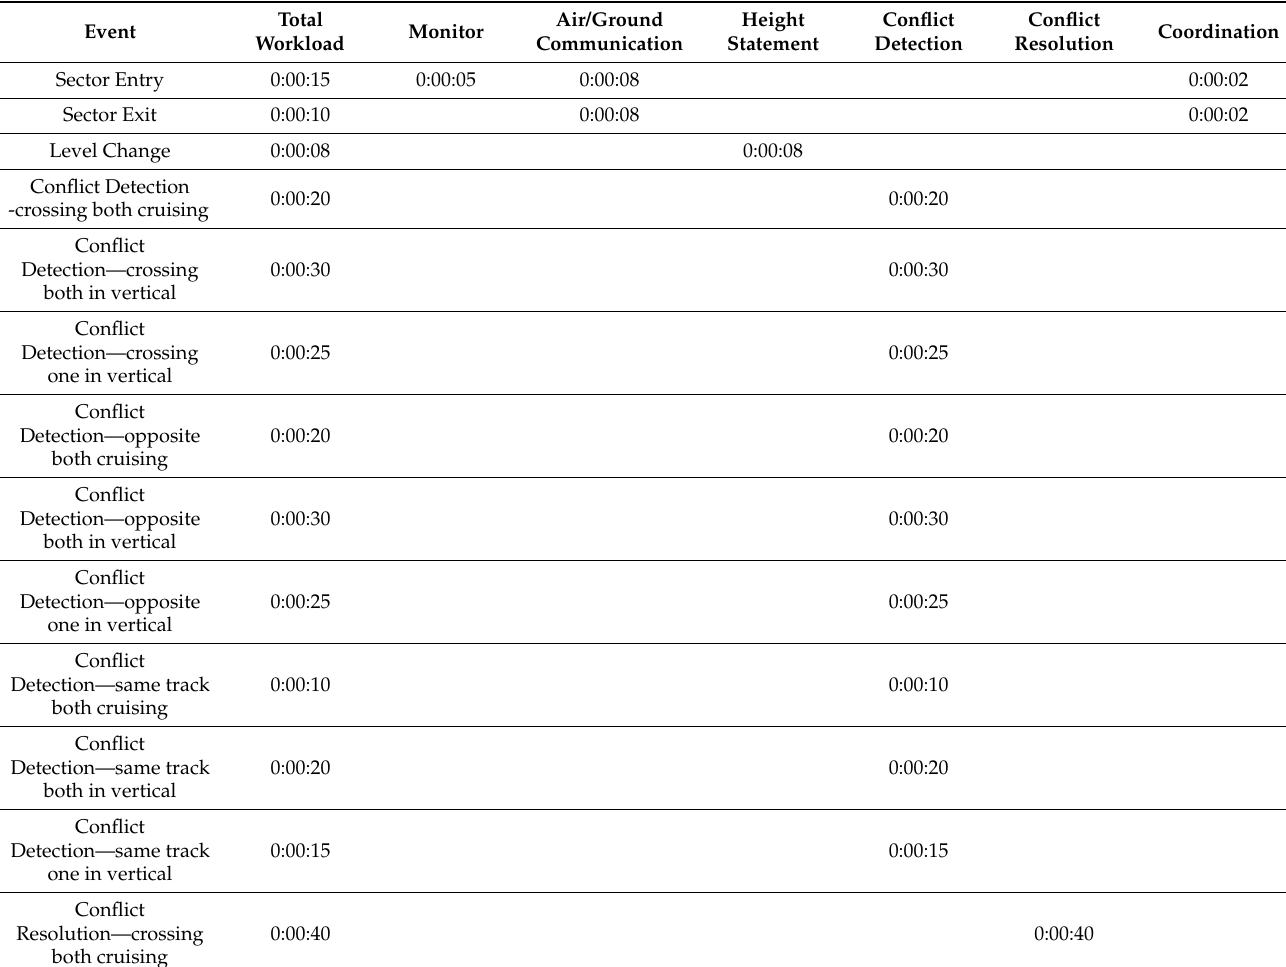
Table A2. Main control events and their workload parameters set in AirTOp simulator.